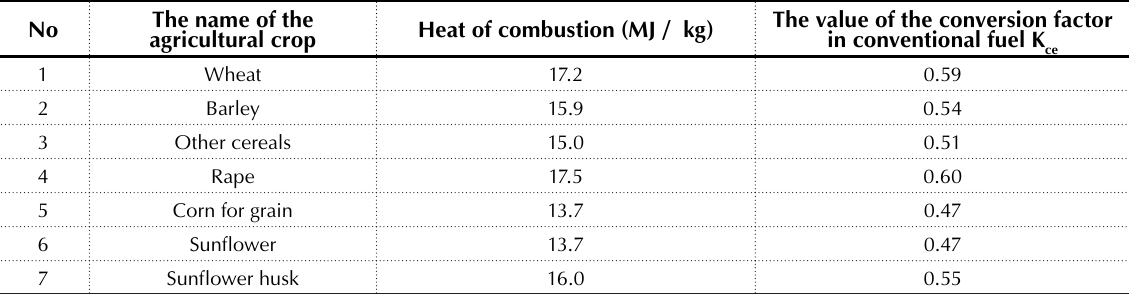
Table 3. Calculation of the coefficient of conversion factor into conventional fuel The name of the No agricultural crop